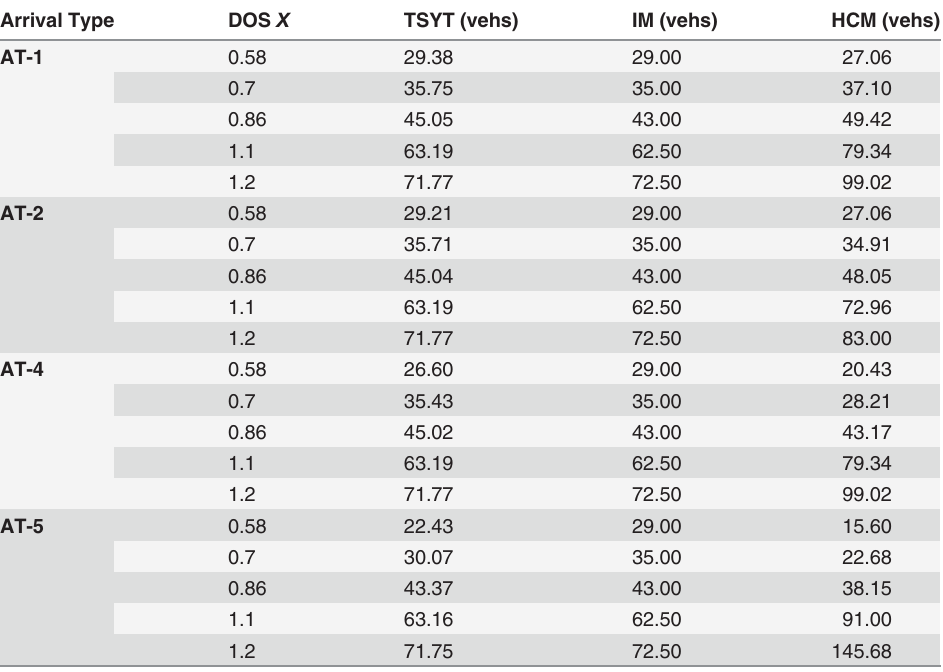
Table 5. Comparison of mean maximum queues Q MM (T = 15 min). Arrival